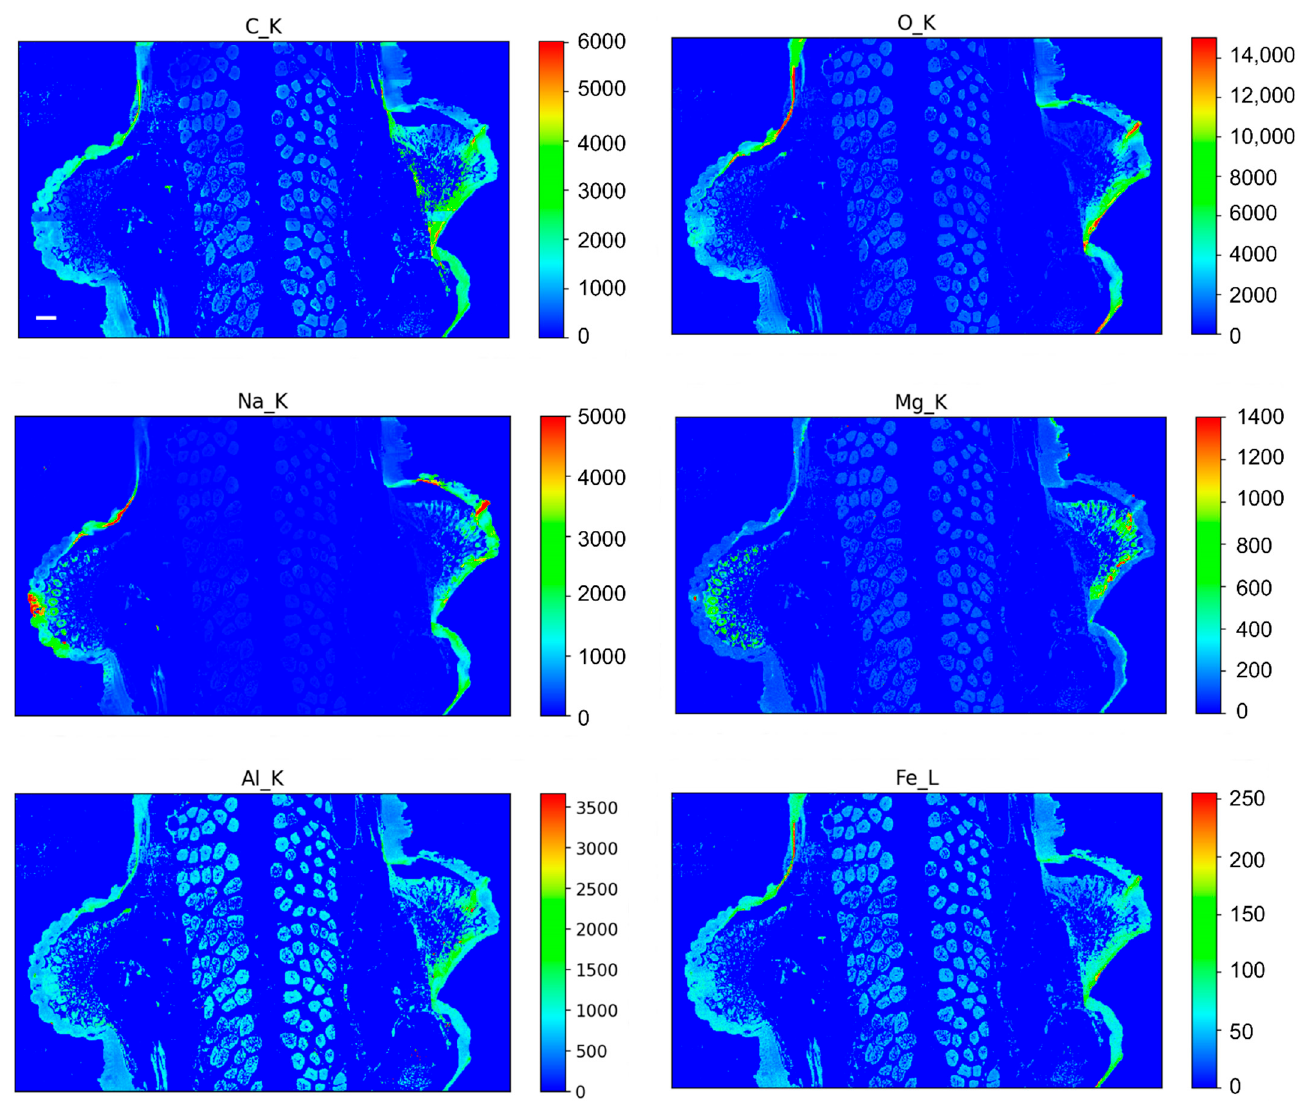
Figure 10. LEXRF maps of C, O, Na, Mg, Al, and Fe acquired at a 1.7 keV excitation energy with a 1.5 µm step size and probe size, and 2 s acquisition time. The STXM images were acquired over an area of 1200 µm × 720 µm with a 1.5 µm step size and probe size, while the XRF signal was collected only on selected areas, based on a preselected absorption threshold value in the absorption signal. Scale bar is 50 µm.